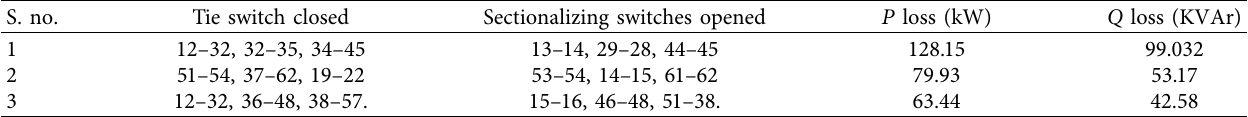
Table 8: Switch position for test 62 bus systems for VSI.